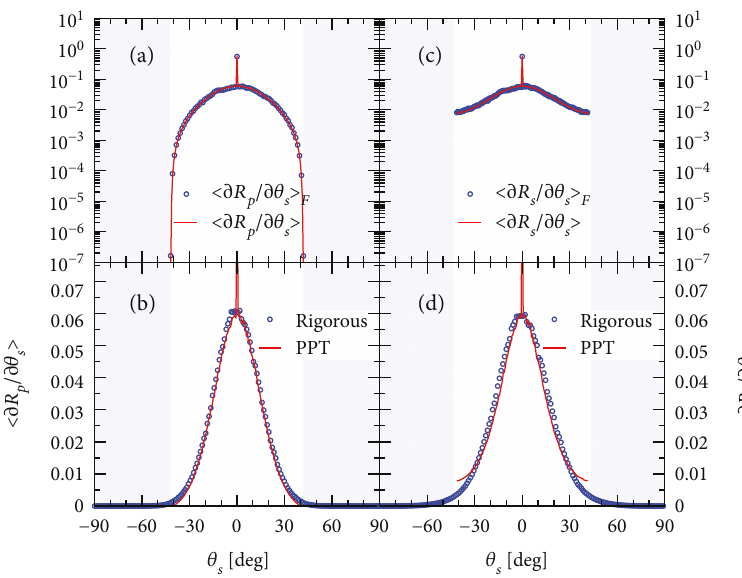
Figure 7: Same as Figure 4 but for a glass-vacuum system ( ε